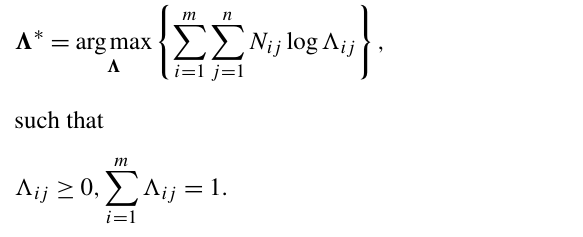
Figure 1. Introduction of intermediate latent states in DBMR for efficient and scalable estimation of (cid:51)